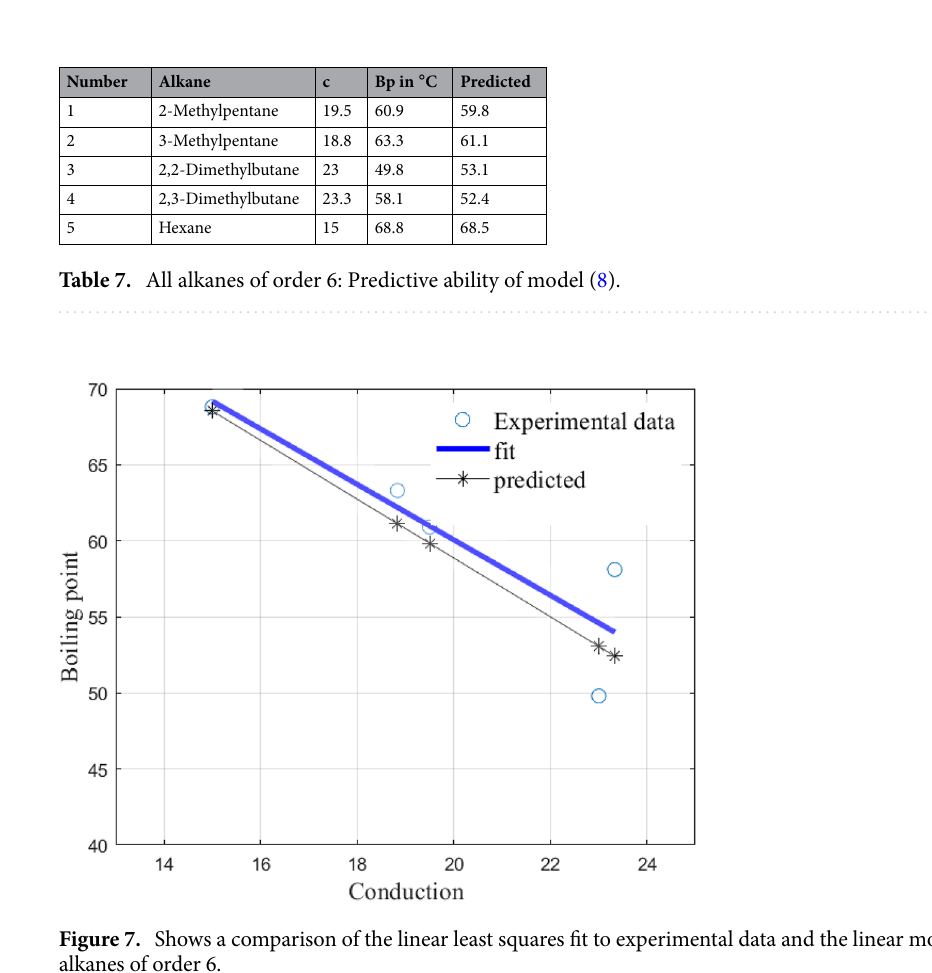
Table 6. Data for 4 alkanes of order n .